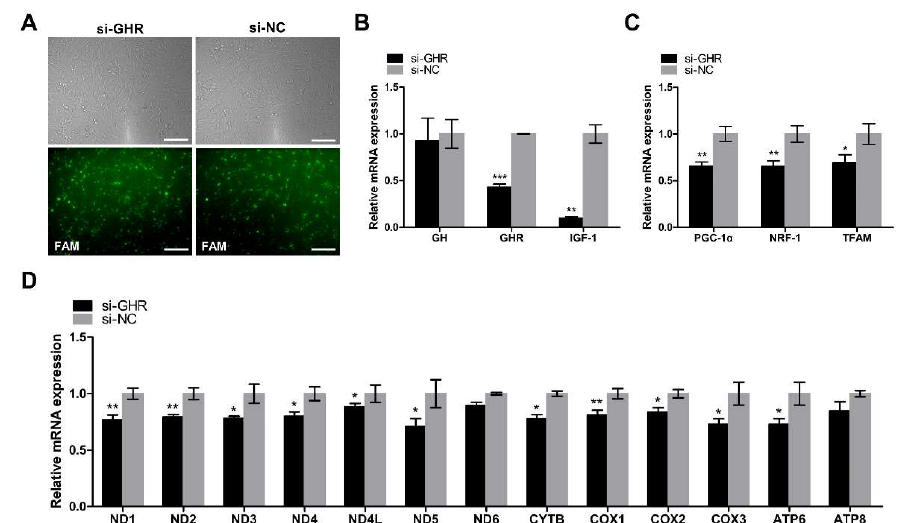
Figure 4. Knockdown of GHR reduced the GH binding activity and downregulated the expression of key regulators of mitochondrial biogenesis and mtDNA-encoded genes in DF-1 cells. ( A ) Transfection efficiency was measured by the fluorescence intensity of FAM siRNA and qRT-PCR at 48 h after transfection with si-GHR and si-NC fragments in DF-1 cells. Bar, 100 μm. The relative mRNA expression of genes involved in the GH–GHR–IGF1 signaling pathway ( B ) and PGC1α–NRF1–TFAM signaling pathway ( C ) were measured by qRT-PCR at 48 h after transfection with si-GHR and si-NC fragments in DF-1 cells. ( D ) mtDNA transcription was measured by qRT-PCR at 48 h after transfection with si-GHR and si-NC fragments in DF-1 cells. Data are expressed as means ± SEM, * p < 0.05; ** p < 0.01; *** p < 0.001.